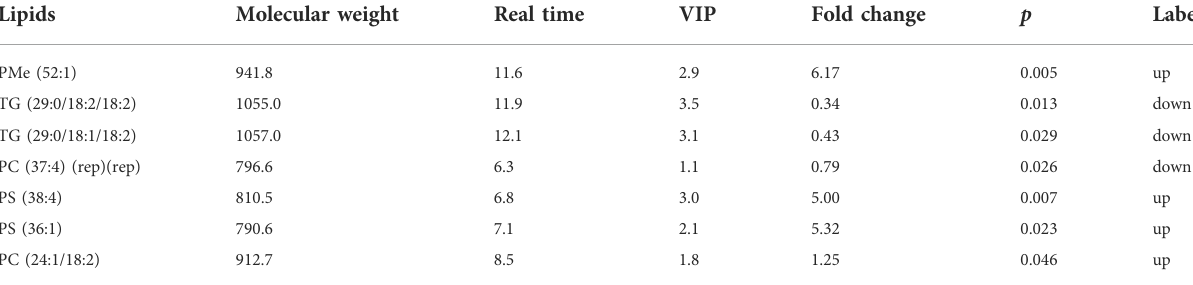
TABLE 4 Identi fi ed differential lipids between the two groups. Lipids Molecular weight Real time VIP Fold change p Label